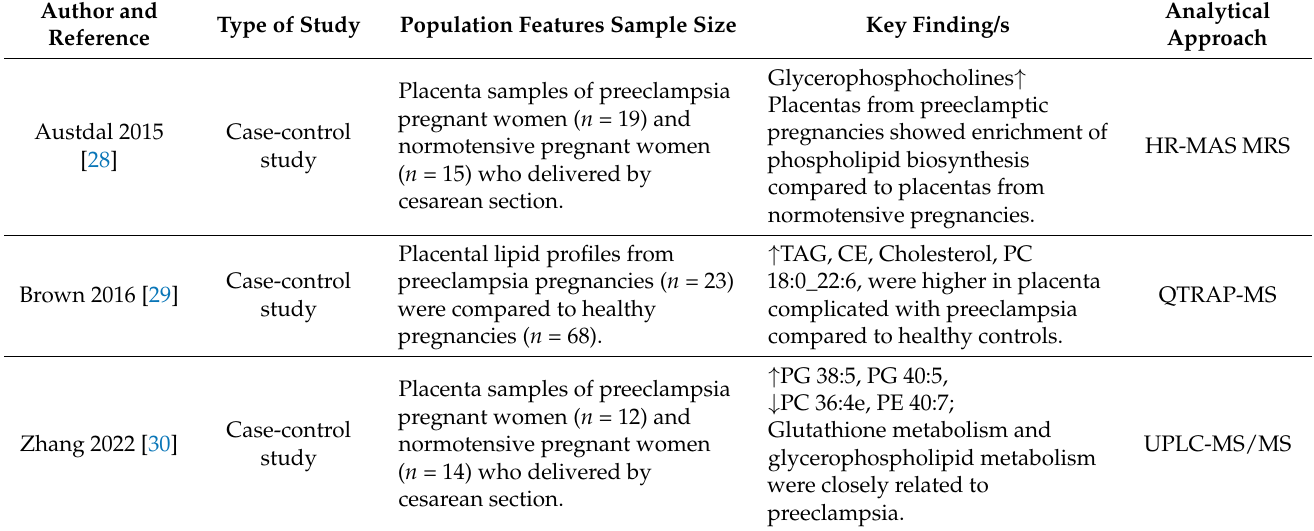
Table 2. Summary of studies on lipid profiling of placental tissue samples of patients with preeclamp- sia. (“ ↑ ” represents an increase in the level of the metabolite; “ ↓ ” represents a decrease in the level of the